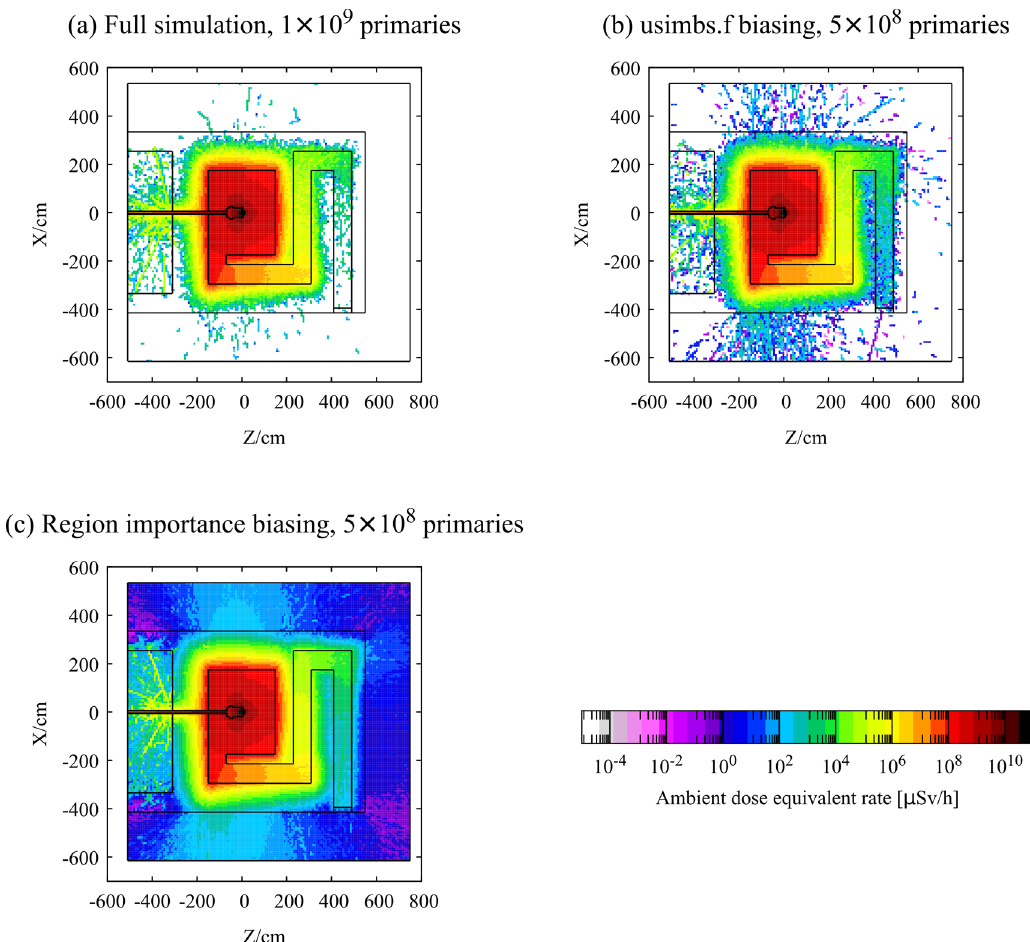
Figure 6. Prompt ambient dose equivalent (in μ Sv/h) at beam level with and without biasing. The usage of biasing techniques improves the statistics, especially in the area far from the source term, even with fewer primaries.